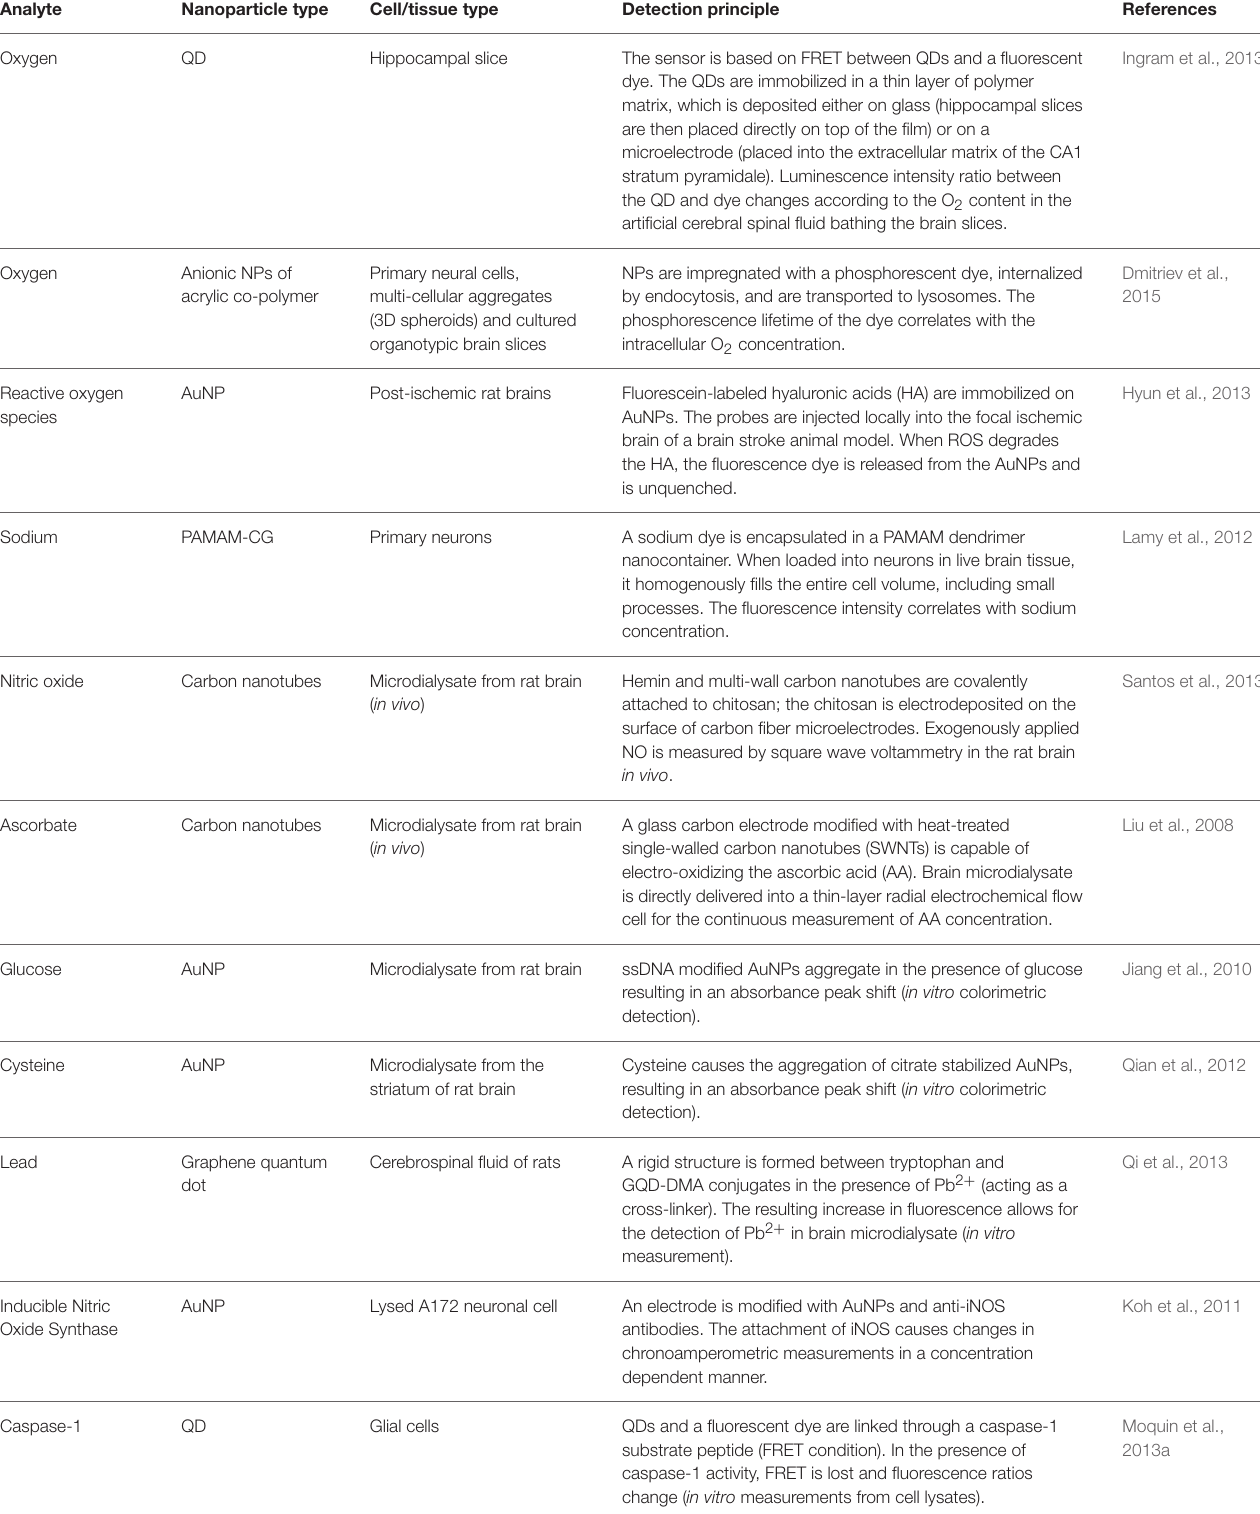
TABLE 1 | Examples of physiologically relevant molecules in neural cells or tissues measured by various nanoparticle-based probes and sensors.